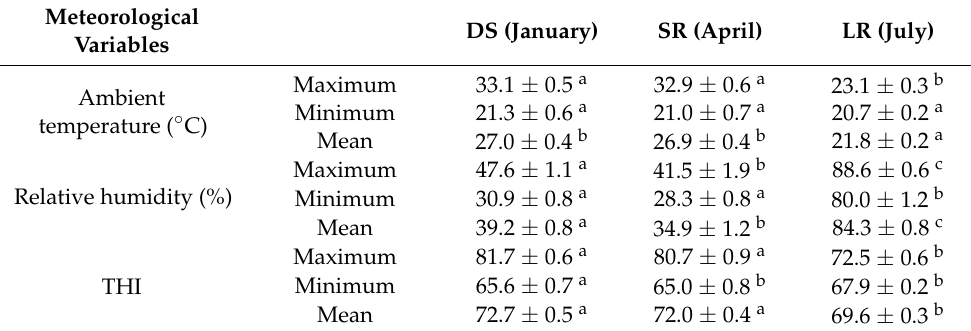
Table 2. Daily meteorological variables during the study period (mean ±